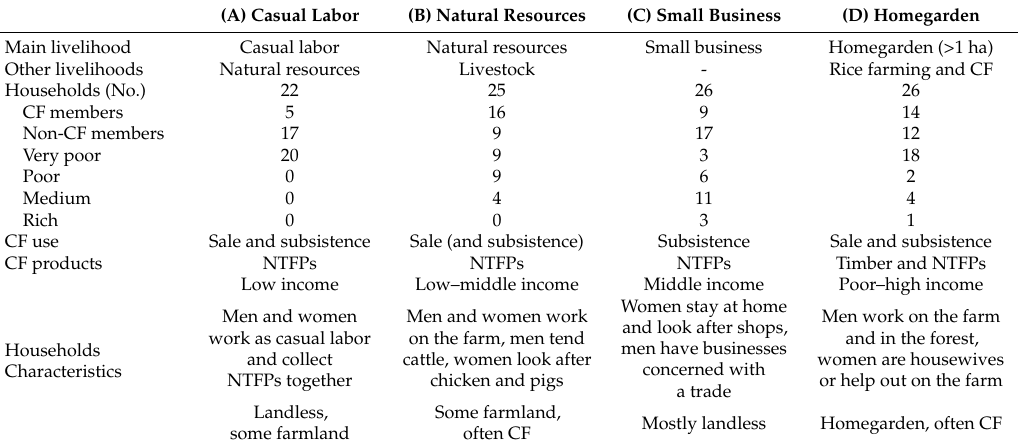
Table 2. Main livelihood strategies of target communities in the Ayeyarwady Delta. NTFPs, non-timber forest products. (CF = community